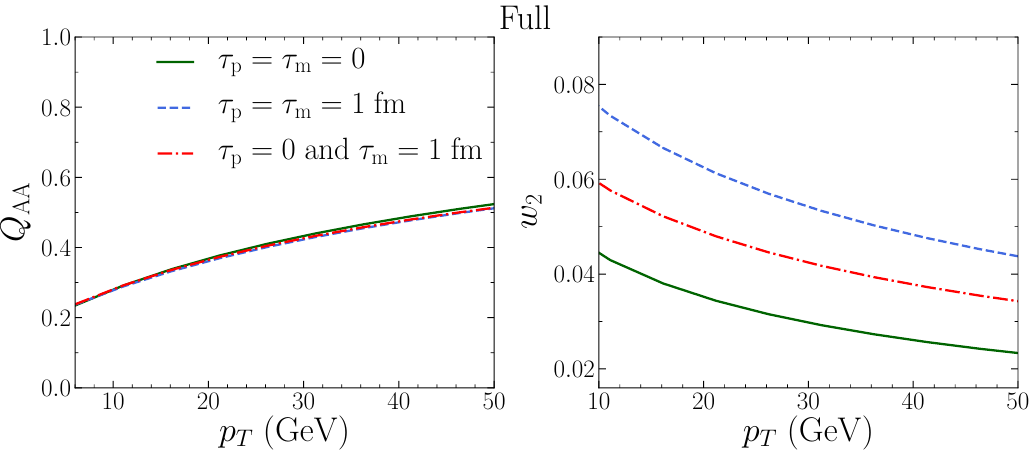
Figure 9 . Our proxies for the R AA (left panel) and high- p T v 2 (right panel) for the 20 - 30% centrality √ class in s NN = 2 . 76 TeV Pb-Pb collisions at the LHC as function of p T obtained using the all-order BDMPS-Z spectrum for the three scenarios analyzed in this manuscript: τ p = τ m = 0 fm (green solid lines); τ p = τ m = 1 fm (blue dashed lines); and τ m = 1 fm and τ p = 0 fm (red dash-dotted